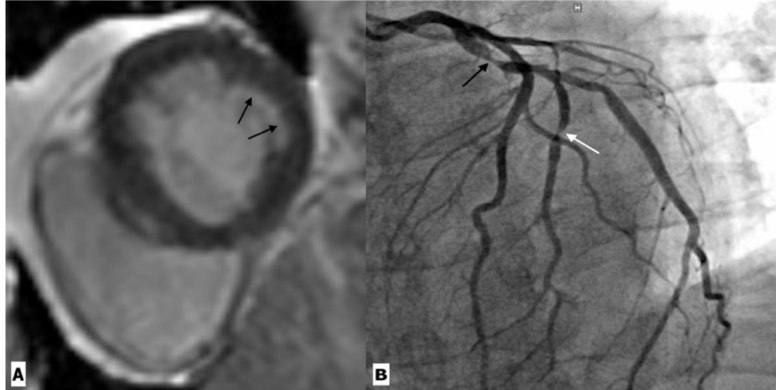
Figure 4. Cardiac magnetic resonance imaging in a 59-year-old HIV-infected male patient with coronary artery disease. ( A ) Basal ventricular short-axis view gadolinium enhancement image showing subendocardial enhancement in the inferolateral segment (black arrow). ( B ) Coronary angiography revealed severe stenosis in the proximal left circumflex artery (black arrow) and its first obtuse marginal branch (white arrow).